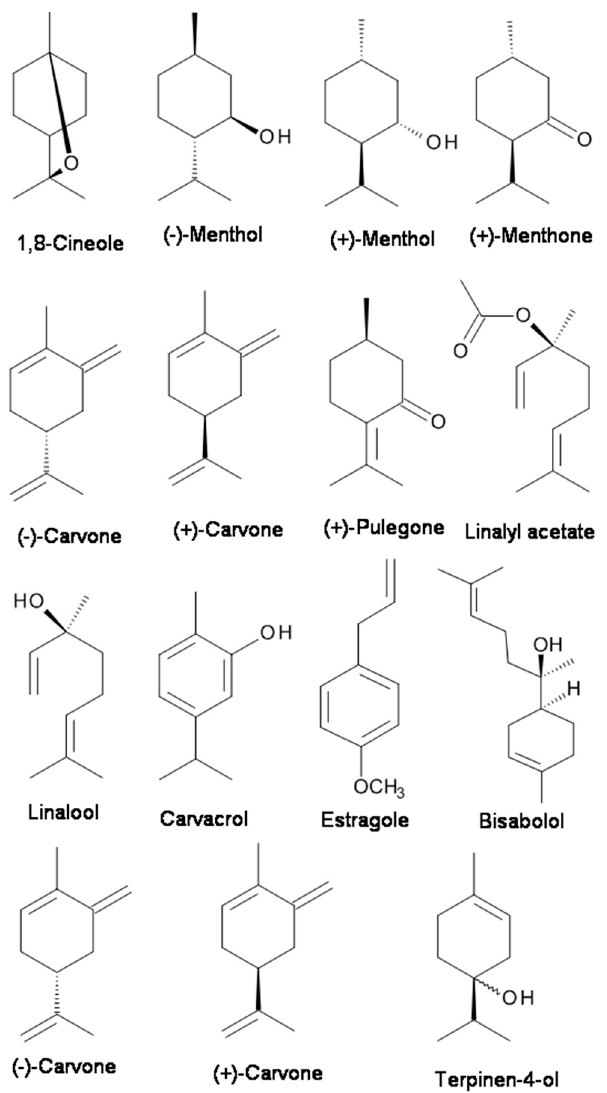
Figure 1. The chemical structures of terpenes with analgesic properties targeting the Na + and transient receptor potential (TRP) channels.